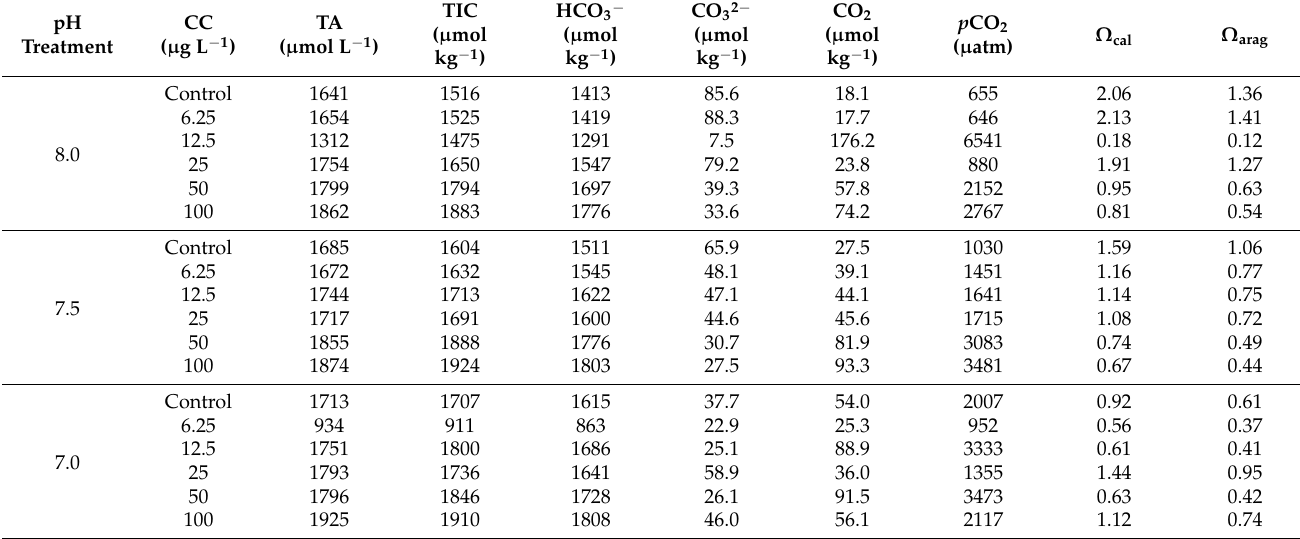
Table 2. Carbonate system speciation in assays exposed to the different scenarios by CO 2 enrichment treatments for the mussel toxicity